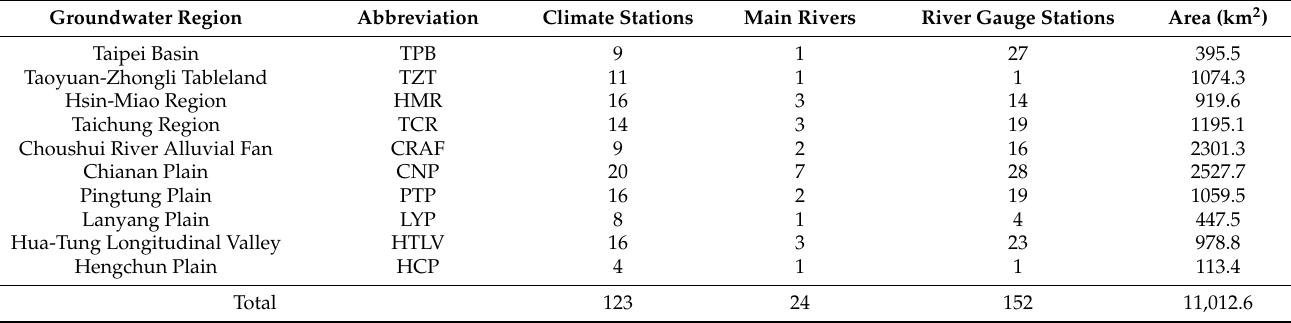
Figure 2. Distribution of groundwater regions and adopted river gauge stations in Taiwan. Table 1. Number of observation stations in each groundwater